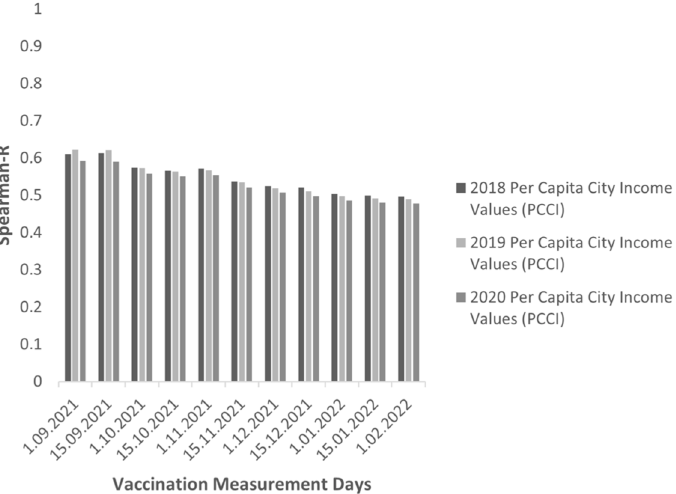
Figure 2. Spearman-R correlation coefficients (per capita city income values (2018–2020) vs. double COVID-19 vaccination percentage of cities (between 1 September 2021 and 1 February 2022 COVID-19 vaccination measurement days)) (All p values calculated for the city’s double COVID-19 vaccination percentage against per capita city income values are less than 0.0001).